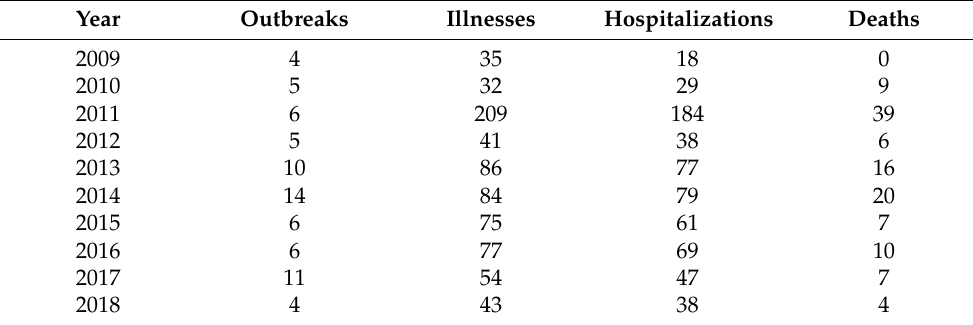
Table 7. NORS outbreak data for Listeria per